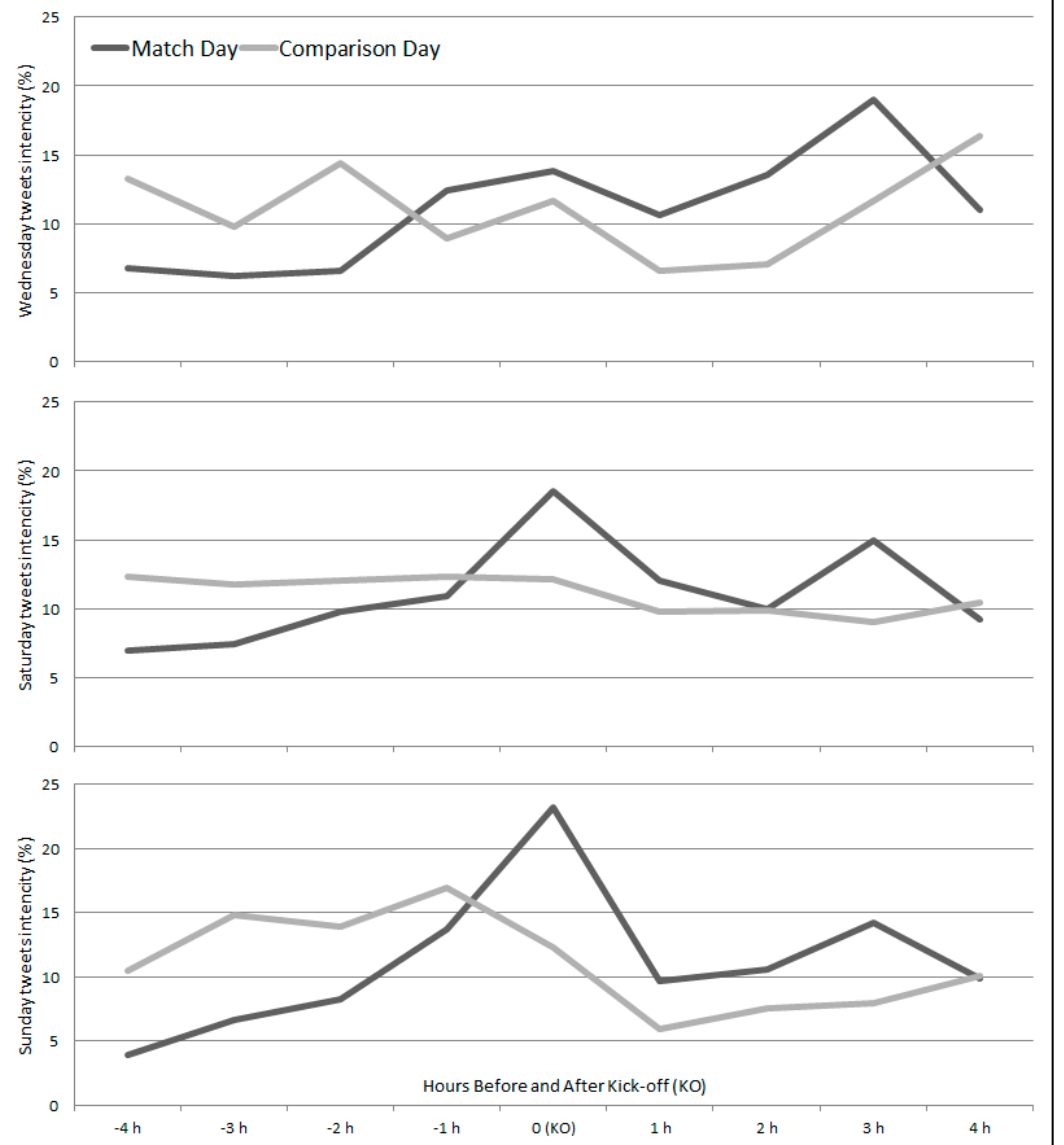
Figure 4. Geotagged tweets intensity (normalized counts by percentage) per hour before and after the kick-off